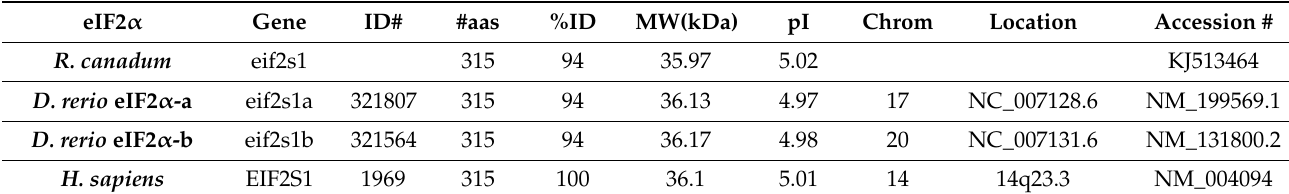
Table 1. Characteristics of cobia eIF2 α .